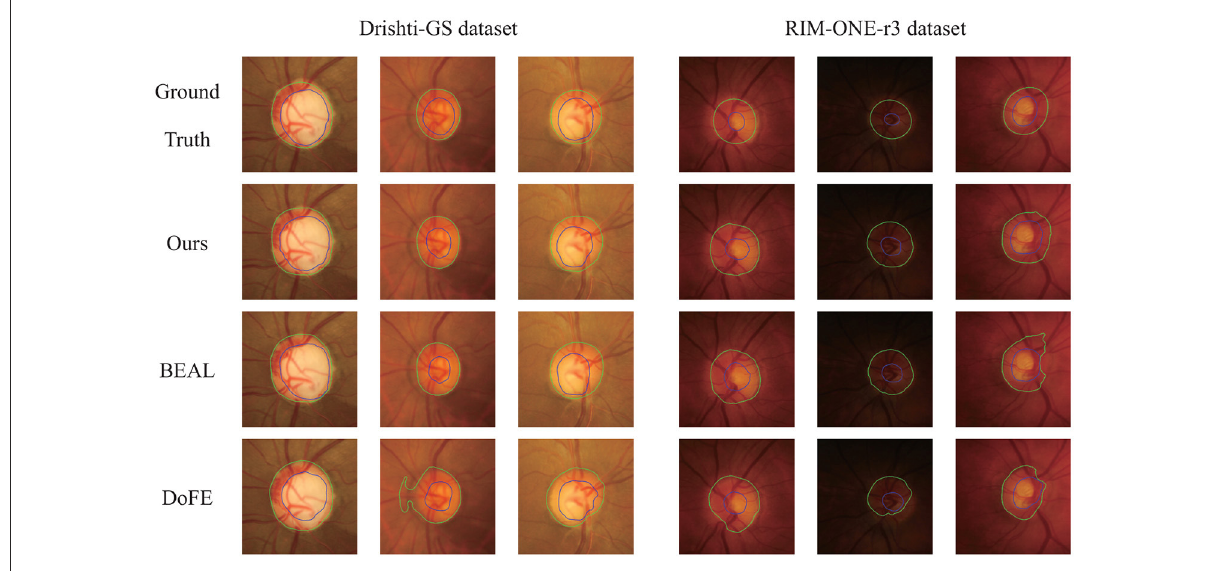
FIGURE4 Qualitative segmentation results were trained on REFUGE and tested on Drishti-GS and RIM-ONE-r3 datasets. The samples were randomly selected from their respective datasets. Green and blue outlines represent the boundaries of OD and OC, respectively.